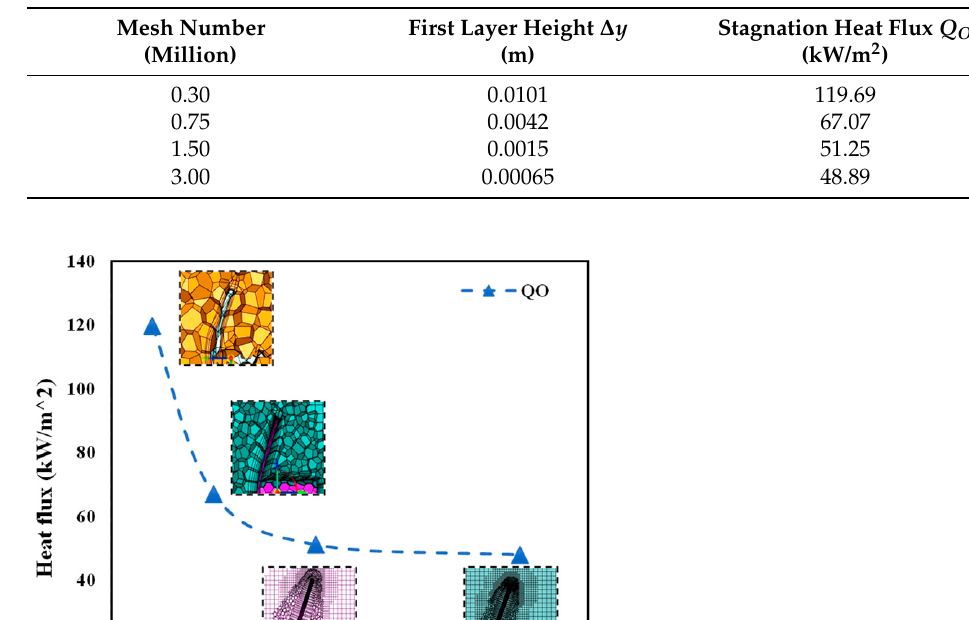
Table 3. Mesh independence veri fi cation results.